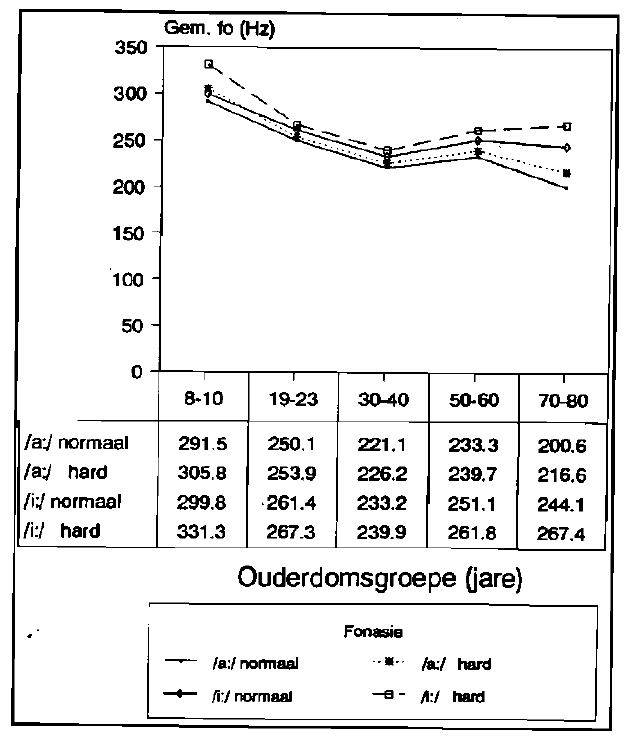
In figuur 2 word die gem. fo van vroue in verskillende ouderdomsgroepe weergegee tydens produksie van die vokale /a:/ en /i:/ met normale en verhoogde luidheid. Figuur 2 vertoon 'n geleidelike verlaging in gem. fo van die vokale /a:/ en /i:/ vanaf die ouderdomsgroep 8- 10 jaar tot by die ouderdomsgroep 30-40 jaar. Hierdie verlaging in die gem. fo van vroue is nie so groot as die verlaging in gem. fo wat by mans in dieselfde tydperk voorkom nie. Die laagste gemiddelde fo-waardes word deur die groep 70-80 jaar vertoon. Die gemiddelde fo- waardes van die verskillende ouderdomsgroepe verskil Dit kom voor asof die invloed van veroudering nie eenvormige gem. fo veranderinge by alle vroue teweegbring nie, terwyl 'n styging in gem. fo by feitlik alle mans voorkom.